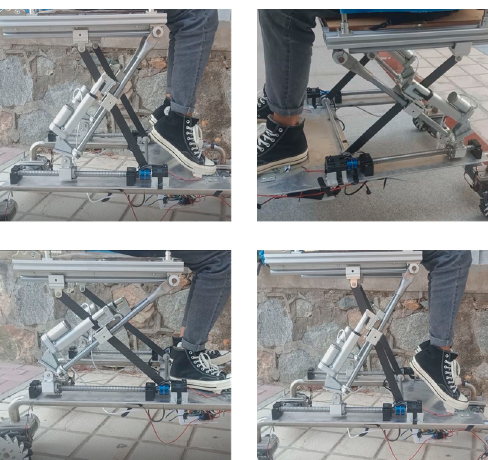
Figure 17. Experimental scenario.